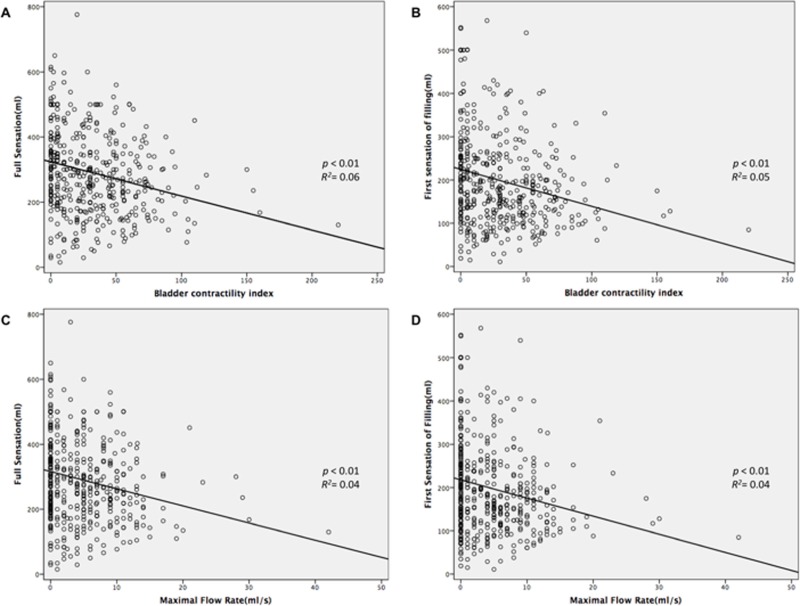
The negative association between bladder contractility and bladder sensation in women with detrusor underactivity.(A) Bladder contractility index (BCI) vs. full sensation (FS). (B) BCI vs. the first sensation of filling (FSF). (C) Maximum flow rate (Qmax) vs. FS. (D) Qmax vs. FSF.